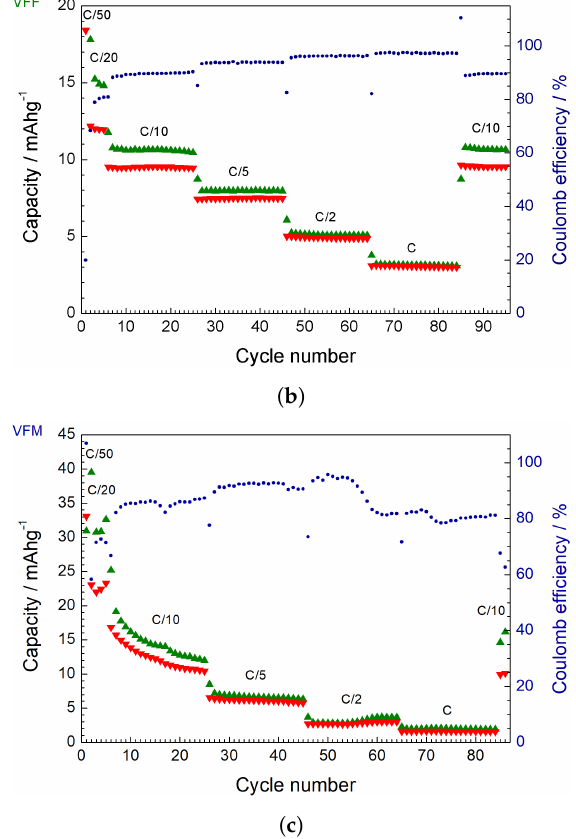
Figure 5. Cyclability and Coulombic efficiency of the studied cathode materials: FFF ( a ), VFF ( b ), and VFM ( c ). Charge (green “up” triangles) and discharge capacities (red “down” triangles) are compared to the Coulombic efficiency (blue dots) in consecutive